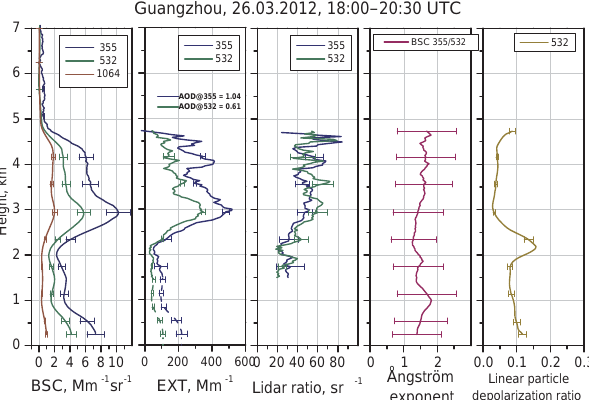
Figure 3. Lidar optical property profiles of particle backscat- ter coefficient (BSC), particle extinction coefficient (EXT), li- dar ratio, backscatter-related Ångström exponent at 355–532nm, and linear particle depolarization ratio at 532nm derived from Polly XT measurement on 26 March 2012 (local time is UTC + 8h, 02:00 to 04:30LT). The profiles are vertically smoothed over 15 range bins, which correspond to 450m. The dashed prolongation of the particle extinction profiles towards the ground results from fitting the BSC to the EXT profile and extrapolating to the